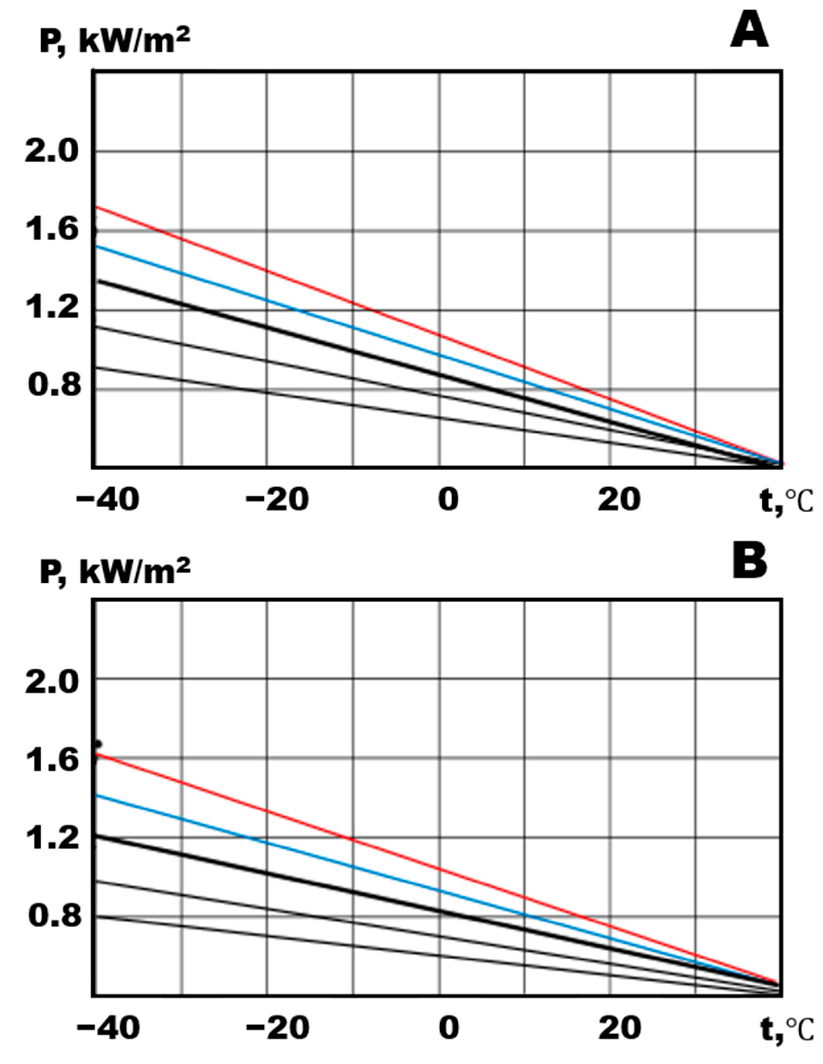
Figure 7. Specific power of heat: ( A ) NPU 1 and ( B ) NPU 2.